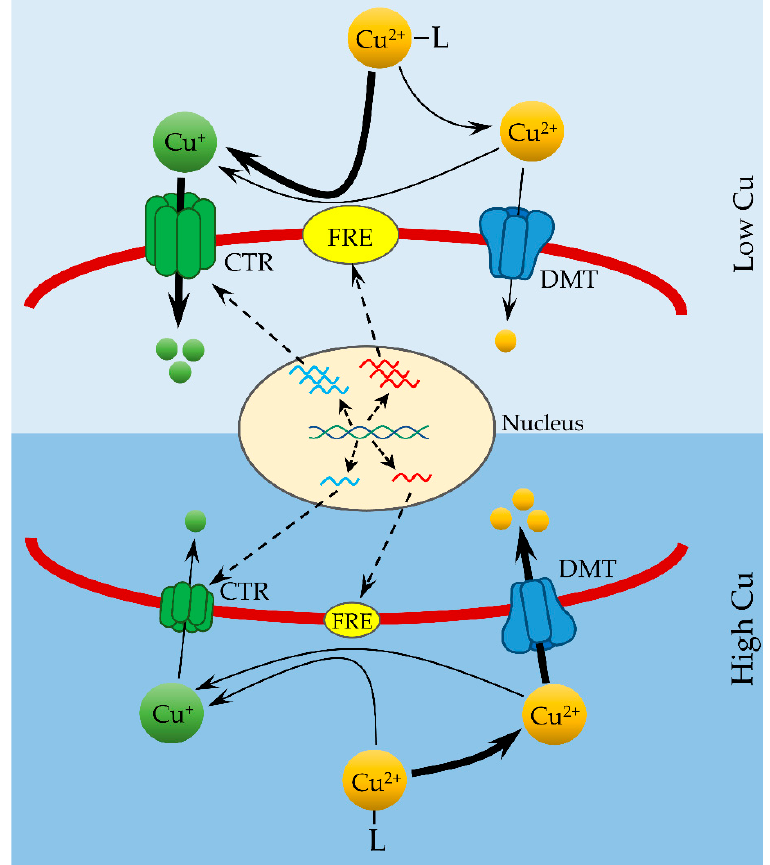
Figure 1. Model of copper uptake by a marine diatom in low and high Cu environments. The graph was replotted according to data reported by Kong and Price [22,23,43,89]. Organically complexed Cu (Cu-L) is dissociated to Cu 2+ by equilibrium or to Cu + by reduction at the cell surface. Cu + is transported across the cell membrane by high-affinity CTR cuprous transporters and Cu 2+ is transported into cells by low-affinity divalent metal transporters (DMT). Expression of CTR transporters and reductases (FRE) are regulated by environmental Cu concentrations. A larger size of the CTR and FRE symbols represents higher abundance of expressed proteins in low Cu environments. The dominant pathway at low or high Cu is identified by the thick lines.